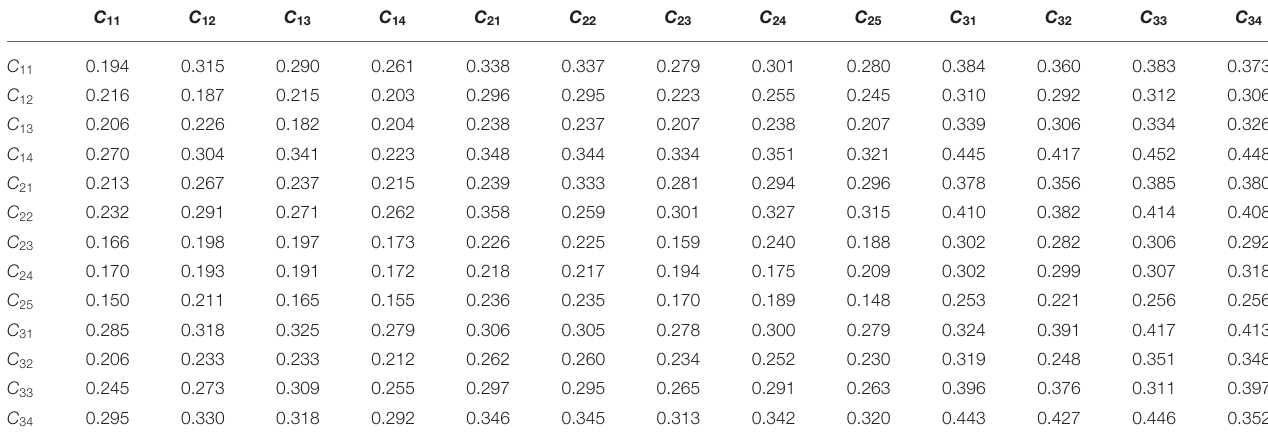
TABLE 3 | The total influence-relationship matrix.